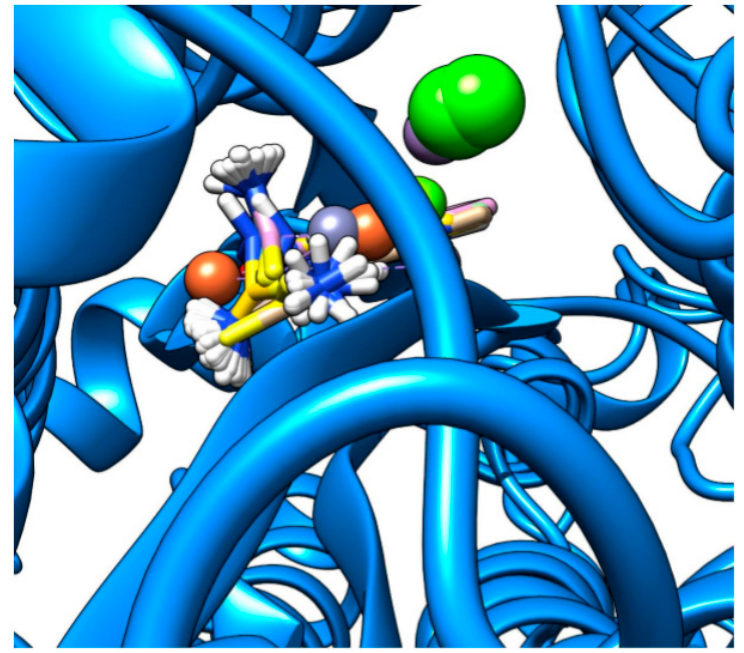
Figure 3. Visualization of three docking sites found in 6VYB. The highest interaction energy was observed at the site bound only by the Mn–Methisazone complex. Molecular graphics and analyses performed with UCSF Chimera, developed by the Resource for Biocomputing, Visualization, and Informatics at the University of California, San Francisco, with support from NIH P41-GM103311.